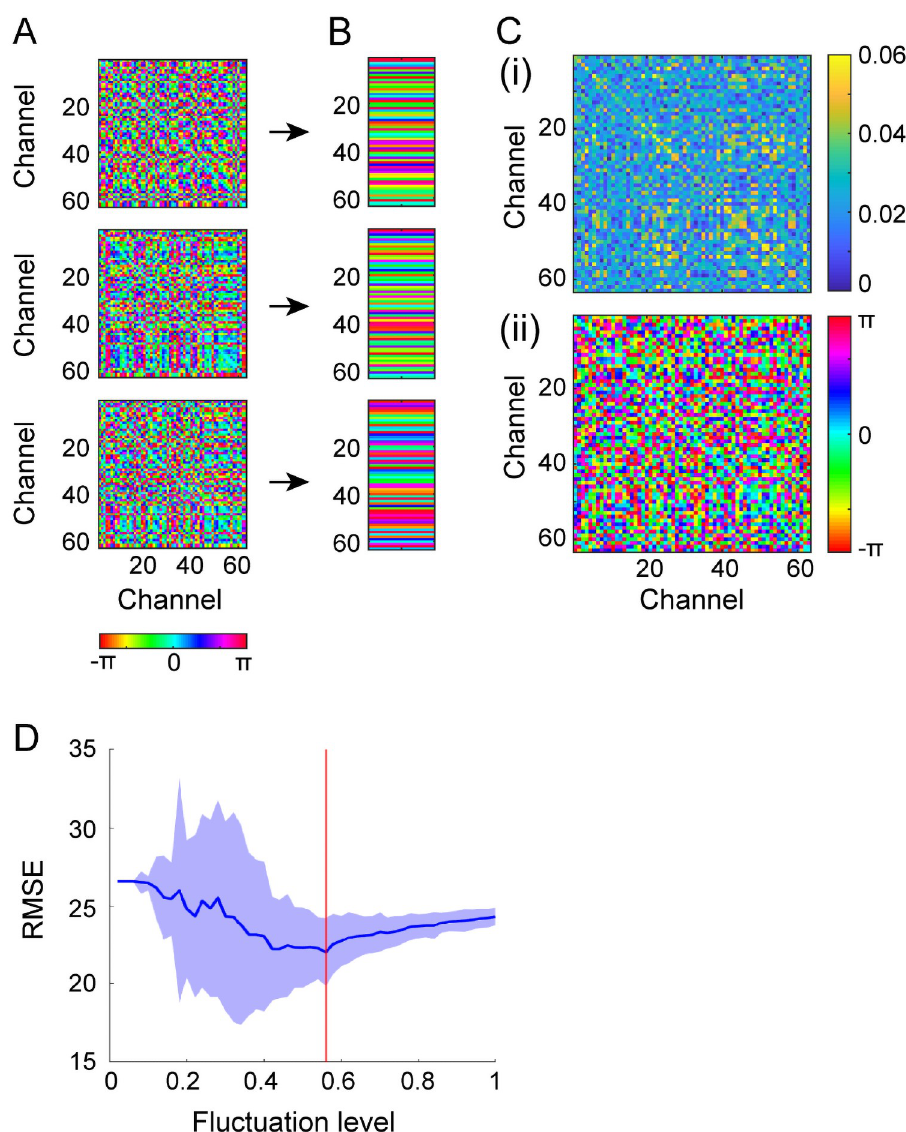
Fig 7. Estimation of PPC connectivity and the level of fluctuations from delta-band phase dynamics. (A) Mean phase differences f c m g between every pair of delta-band CSD phases with respect to each delta-alpha PAC state μ . (B) ij The corresponding phase patterns { θ μ } (regarded as the synchronous states in the model). (C) The estimated PPC connectivity C δ as a complex-valued matrix with absolute part f J d g (i) and argument part f b d g (ii). (D) The estimated ij ij fluctuation level ^ D . The synchronous states (B) combined with the Kuramoto model resulted in PPC connectivity (C), and the Kuramoto model with PPC connectivity was used for estimation of the fluctuation level (D). The data used in this Figure correspond to Figs 3A to 3D(i) and 4A to